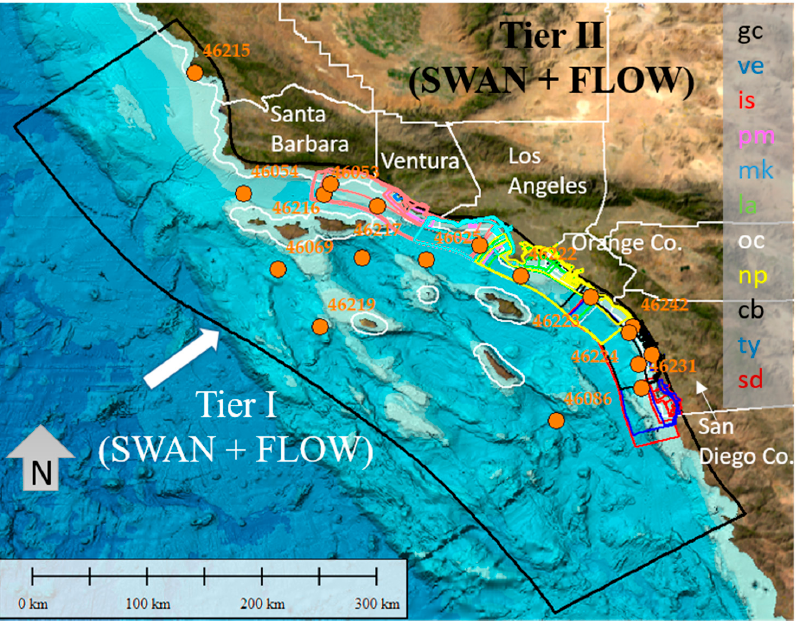
Figure 8. Map showing Tier I (black) and Tier II (colored) model grid extents. Wave observation buoys used in model validation (Section 3 and Appendix B) are shown with orange circles.